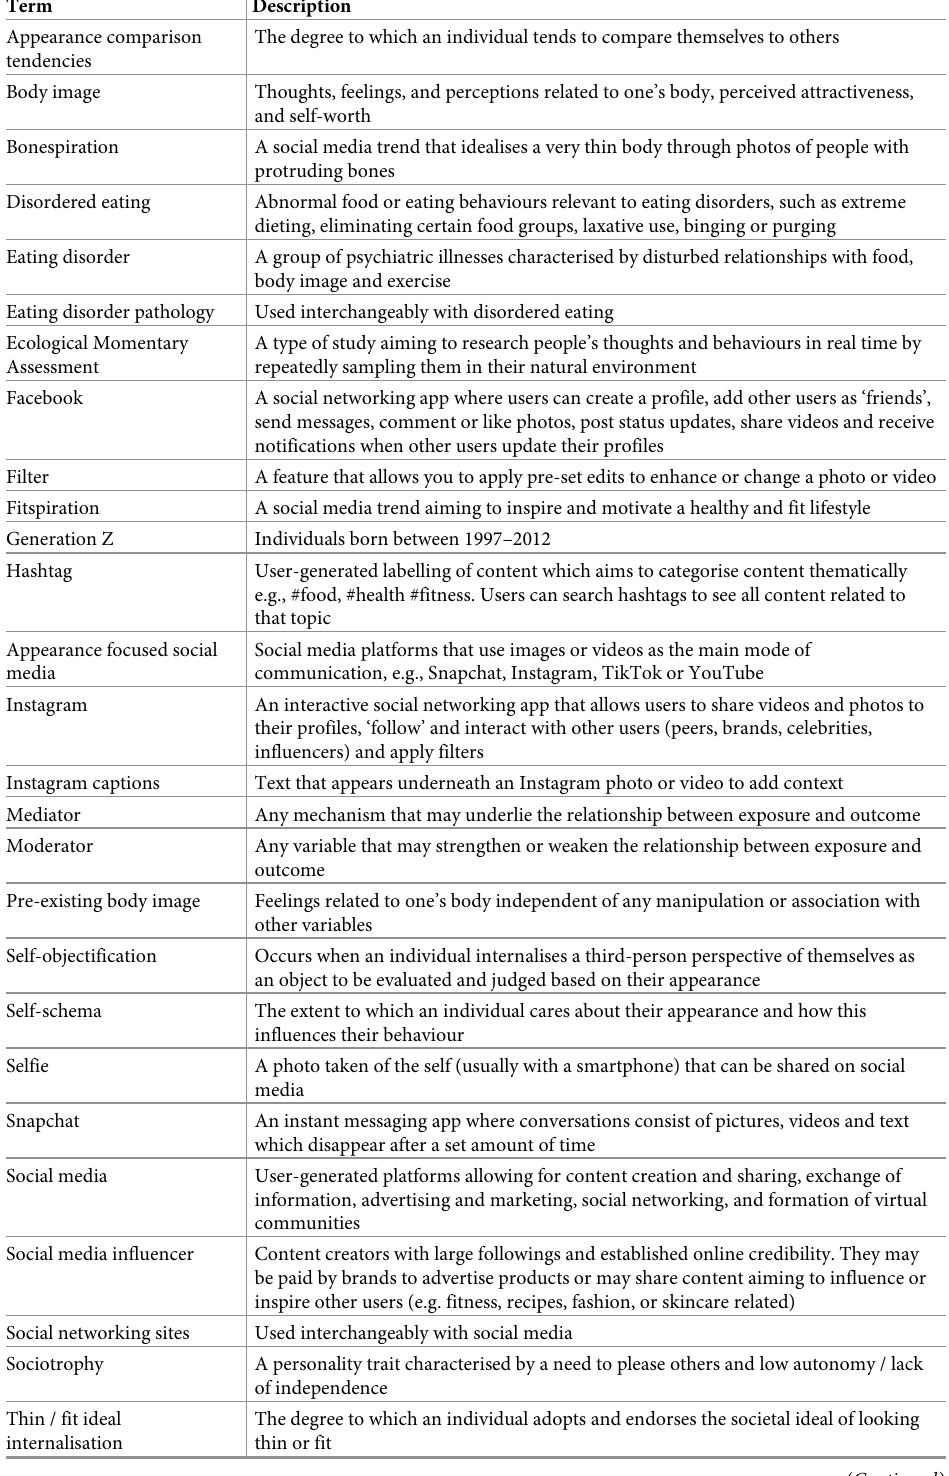
Table 3. Glossary of terms associated with social media, body image and eating